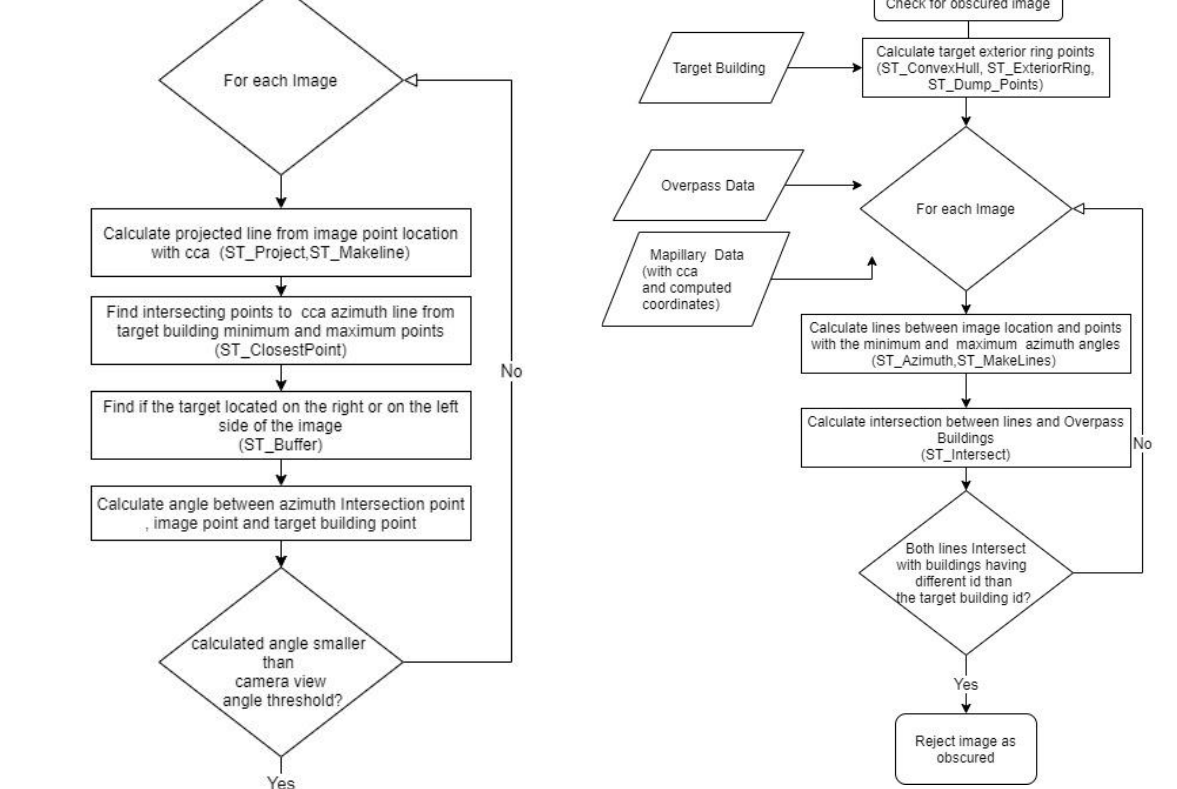
Figure 10. Process flow for checking if the images obscured by another